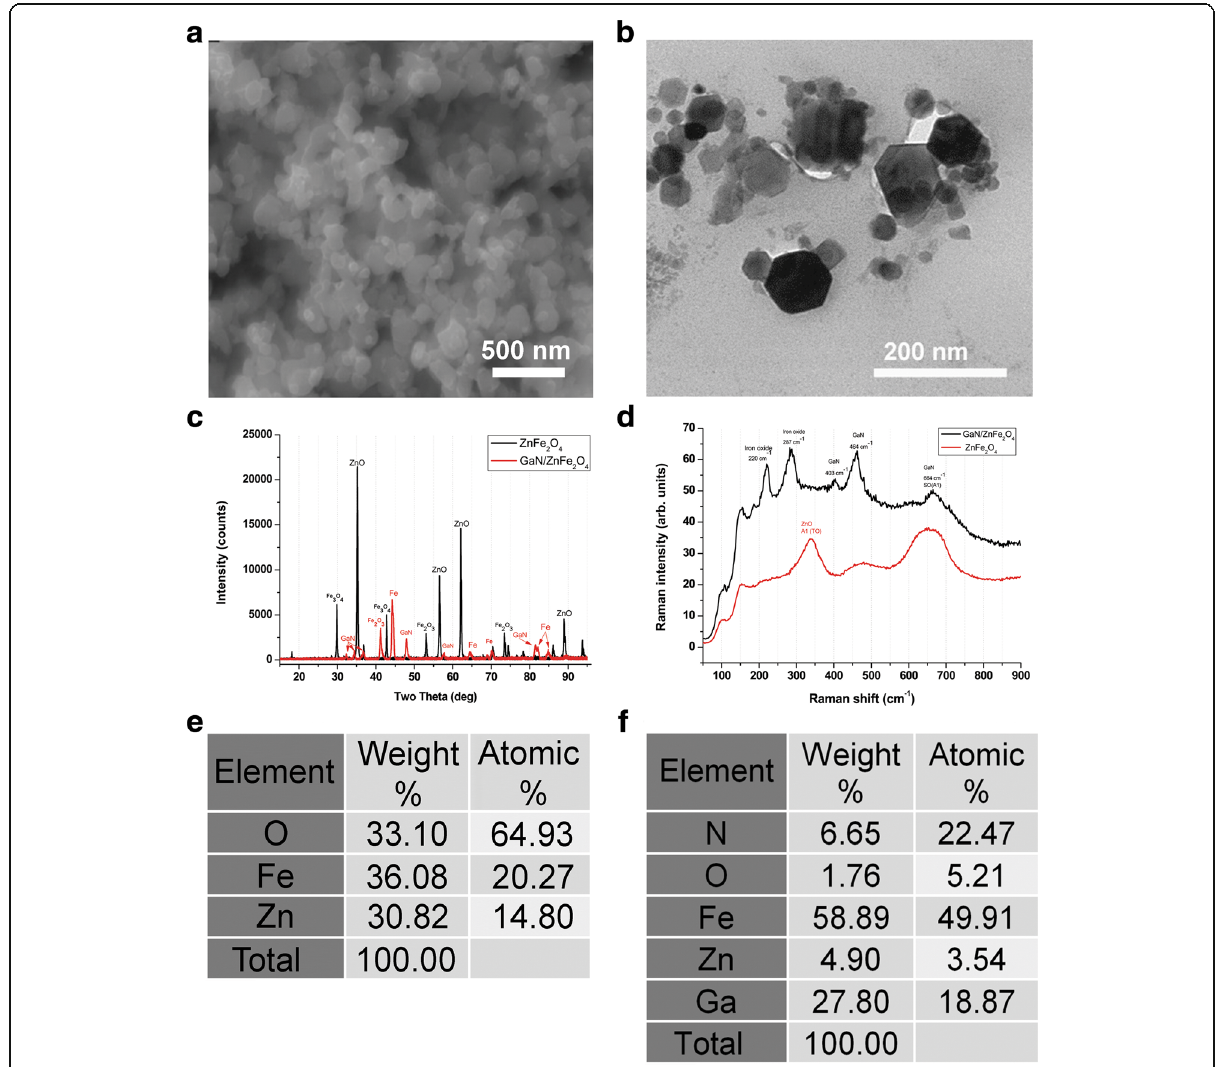
Fig. 1 Analysis of nanoparticles. a SEM picture of GaN nanoparticles grown on sacrificial nanoparticles of ZnO alloyed with Fe 2 O 3 . b TEM image of the resultant GaN/Fe nanoparticles. c XRD pattern of initial ZnFe 2 O 4 nanoparticles and resultant GaN/ZnFe 2 O 4 nanoparticles. d Raman spectra of the initial and resultant nanoparticles after GaN growth. e EDX analysis of ZnO alloyed with Fe 2 O 3 nanoparticles. f EDX analysis of resulted nanoparticles after the growth of the GaN